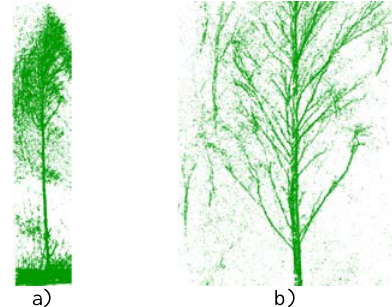
Figure 1. Input TLS point clouds with noise.